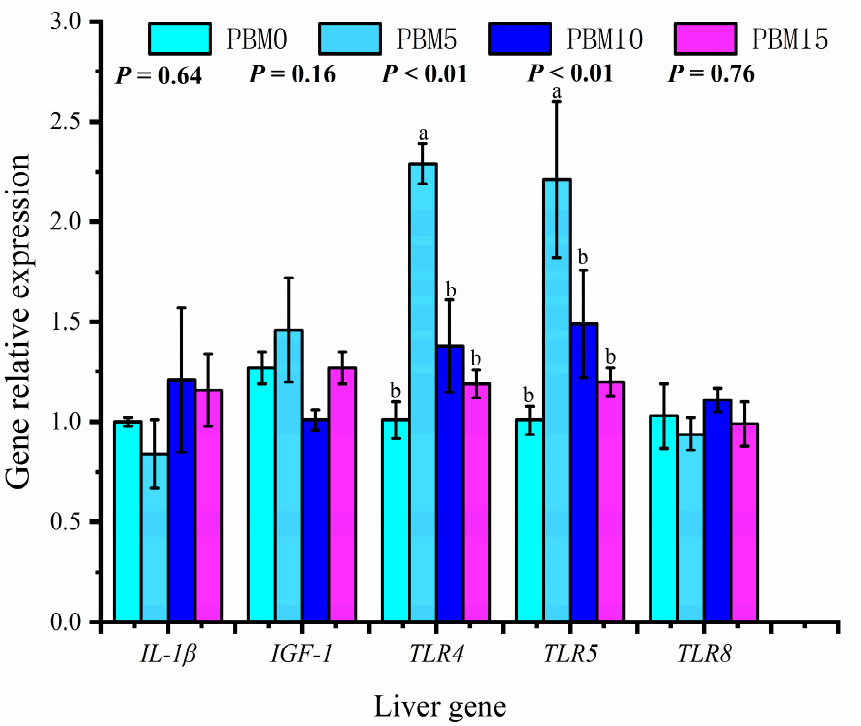
Figure 7. Effects of dietary replacement of fish meal with poultry by − product meal on the liver gene expression of Chinese soft − shelled turtle. Error bars was represented the mean ± standard error (n = 6). Different letters indicated significant differences between groups ( p < 0.05).